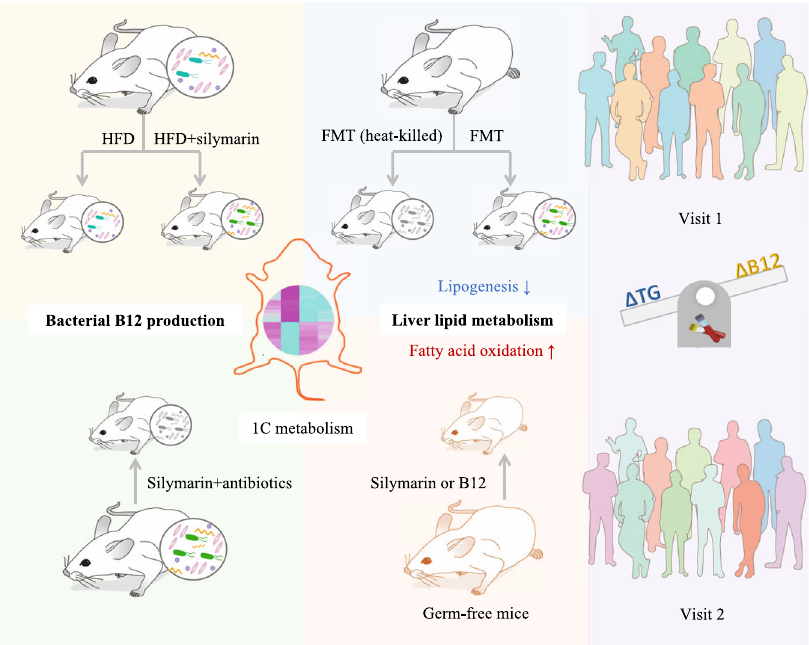
Fig. 6 | Main fi ndings of the present study. Microbially produced B12 was shown to be responsible forthe lipid-lowing effect of silymarininbothratsand germ-free mice. Additionalliver transcriptome analyses demonstratedthatthe improvement